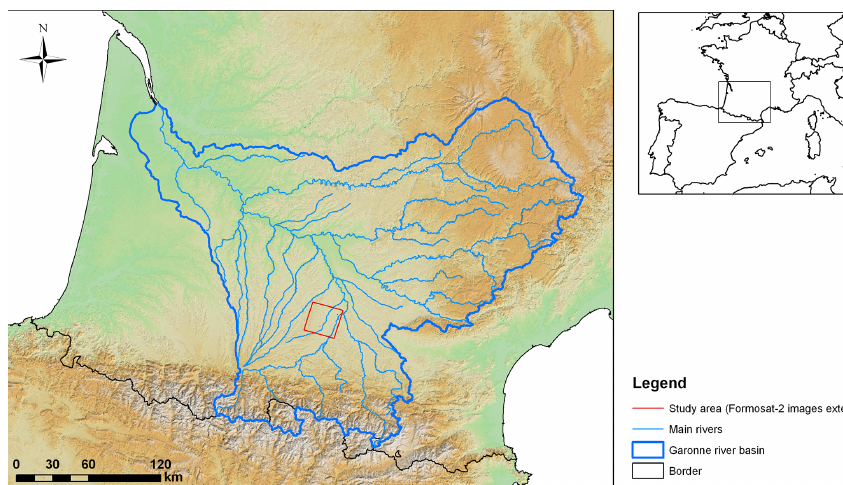
Figure 1. Study area location (red).